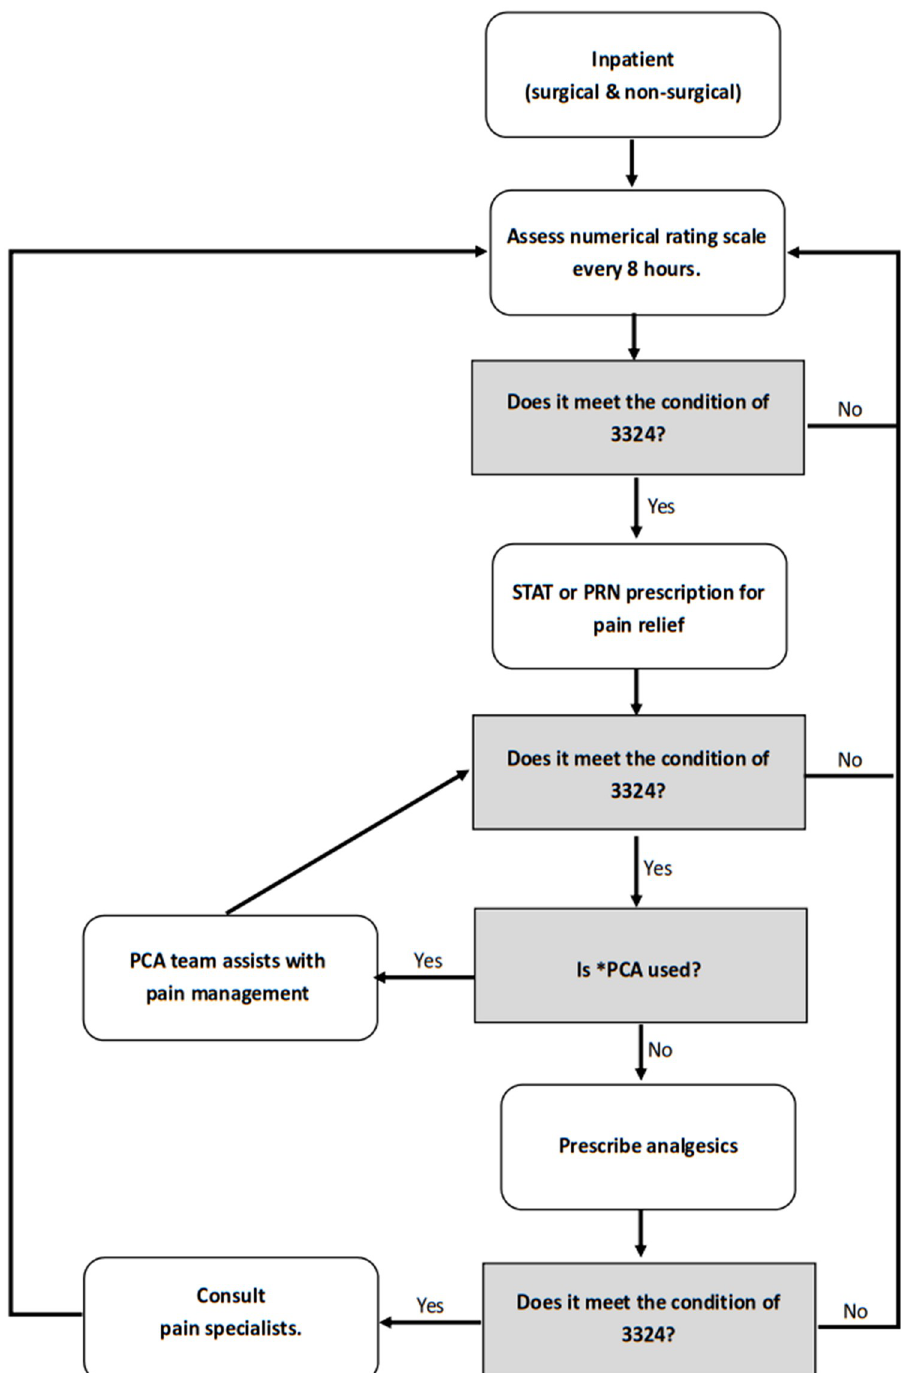
Fig 1. Standard process for inpatient pain management. Based on clinical care guidelines and evidence-based medicine, we developed the “Standard Process for Inpatient Pain Management”, and set up quality indicators from pain management process for auditing and feedback [16–19]. * PCA: patient-controlled analgesia.